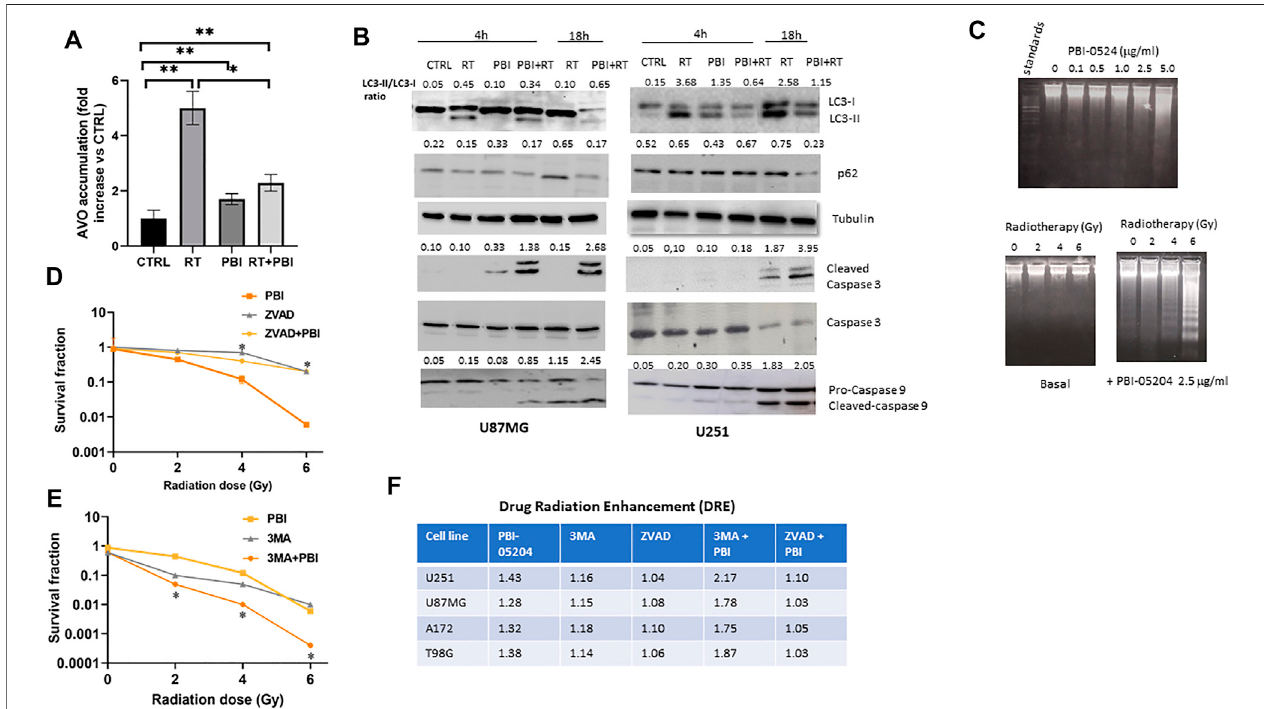
FIGURE 6 | Combination of PBI-05204 and radiotherapy leads to apoptotic cell death in U87MG cells. (A) Acridine Orange Staining (AVO) of U87MG cells treated withRT,PBI-05204(2.5 μ g/ml),andRTplusPBI-05204.AVOaccumulationwasmeasuredbyafoldchangesvsCTRLanddataarepresented asmean±SEfromthree separateexperiments.* p < 0.05,** p < 0.01. (B) WesternblotofLC3-I/IIandp62(asautophagymarkers),andcaspase3&9(apoptosismarker)inU87MGandU251cells after being treated with RT (4 Gy), PBI-05204 (2.5 μ g/ml) and combination RT + PBI-05204. (C) DNA fragmentation was determined by DNA laddering in U87MG cellsafter treatmentwith differentdoses ofPBI-05204 (0.1, 0.5, 1,2.5 and 5 μ g/ml)and RT(2, 4, 6 Gy)aloneorin combination withPBI-05204 at 2.5 μ g/ml for 16 h. (D) Radio-sensitizingeffects ofPBI-05204 in U87 cells pretreated with caspase-3 inhibitor, Z-DEVD-FMK.* p < 0.05 vs PBI-05204. (E) Radio-sensitizing effects of PBI-05204 in U87 cells pretreated with 3 methyl adenine, an inductor of lysosomal self-degradation. * p < 0.05 vs PBI-05204. The modulation of radiosensitivity was measured in U87MG cells that were treated with Z-VAD-FMK (10 mM), or 3 MA (3 mM), and PBI-05204 (2.5 μ g/ml) before administration with RT. At the end of experiment(21 days),colonieswerestainedwithcrystalvioletandcounted.Dataarepresentedasmean±SEfromthreeexperiments. (F) ADrugRelatedEnhancement (DER) for the PBI-05204 co-administered with ZVAD-FMK or 3 MA in GBM